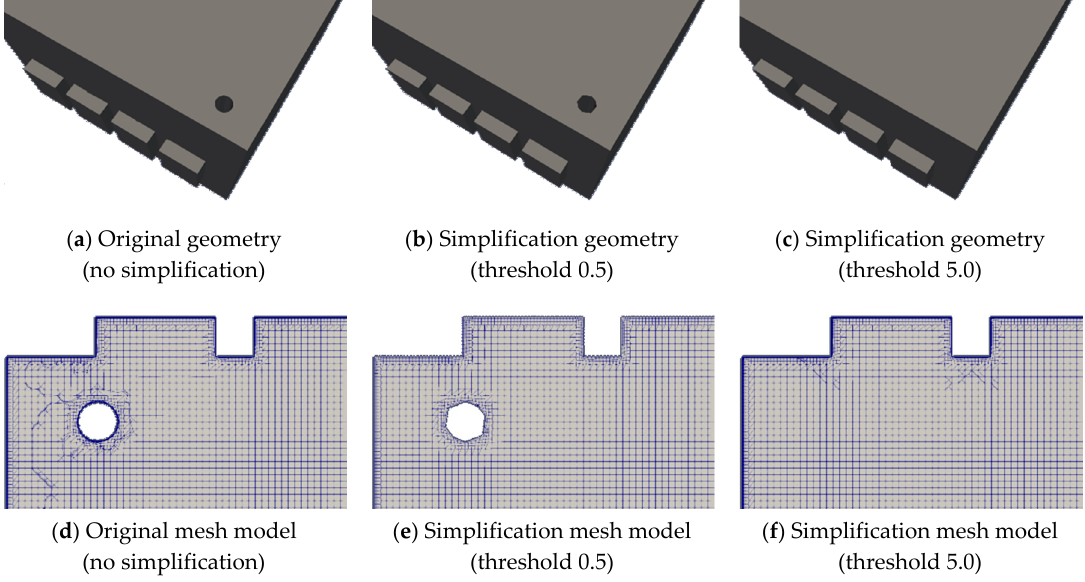
Figure 2. Example of geometry simplification function.